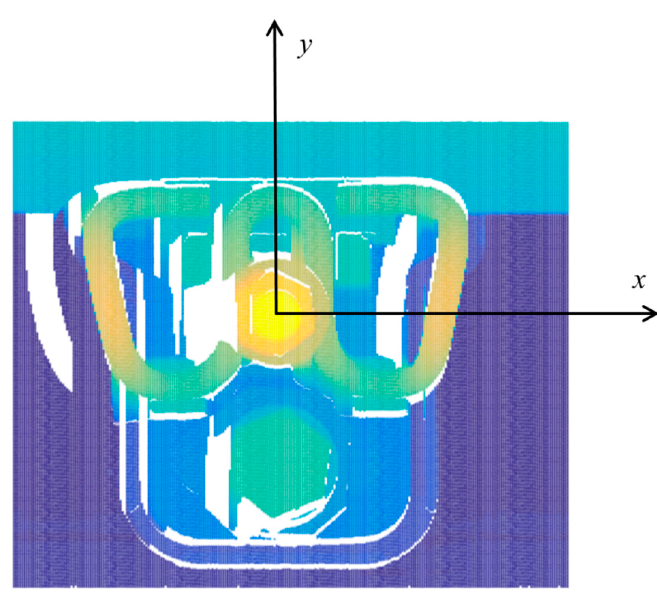
Figure 11. The coordinate system of a WJ-7 fastener.